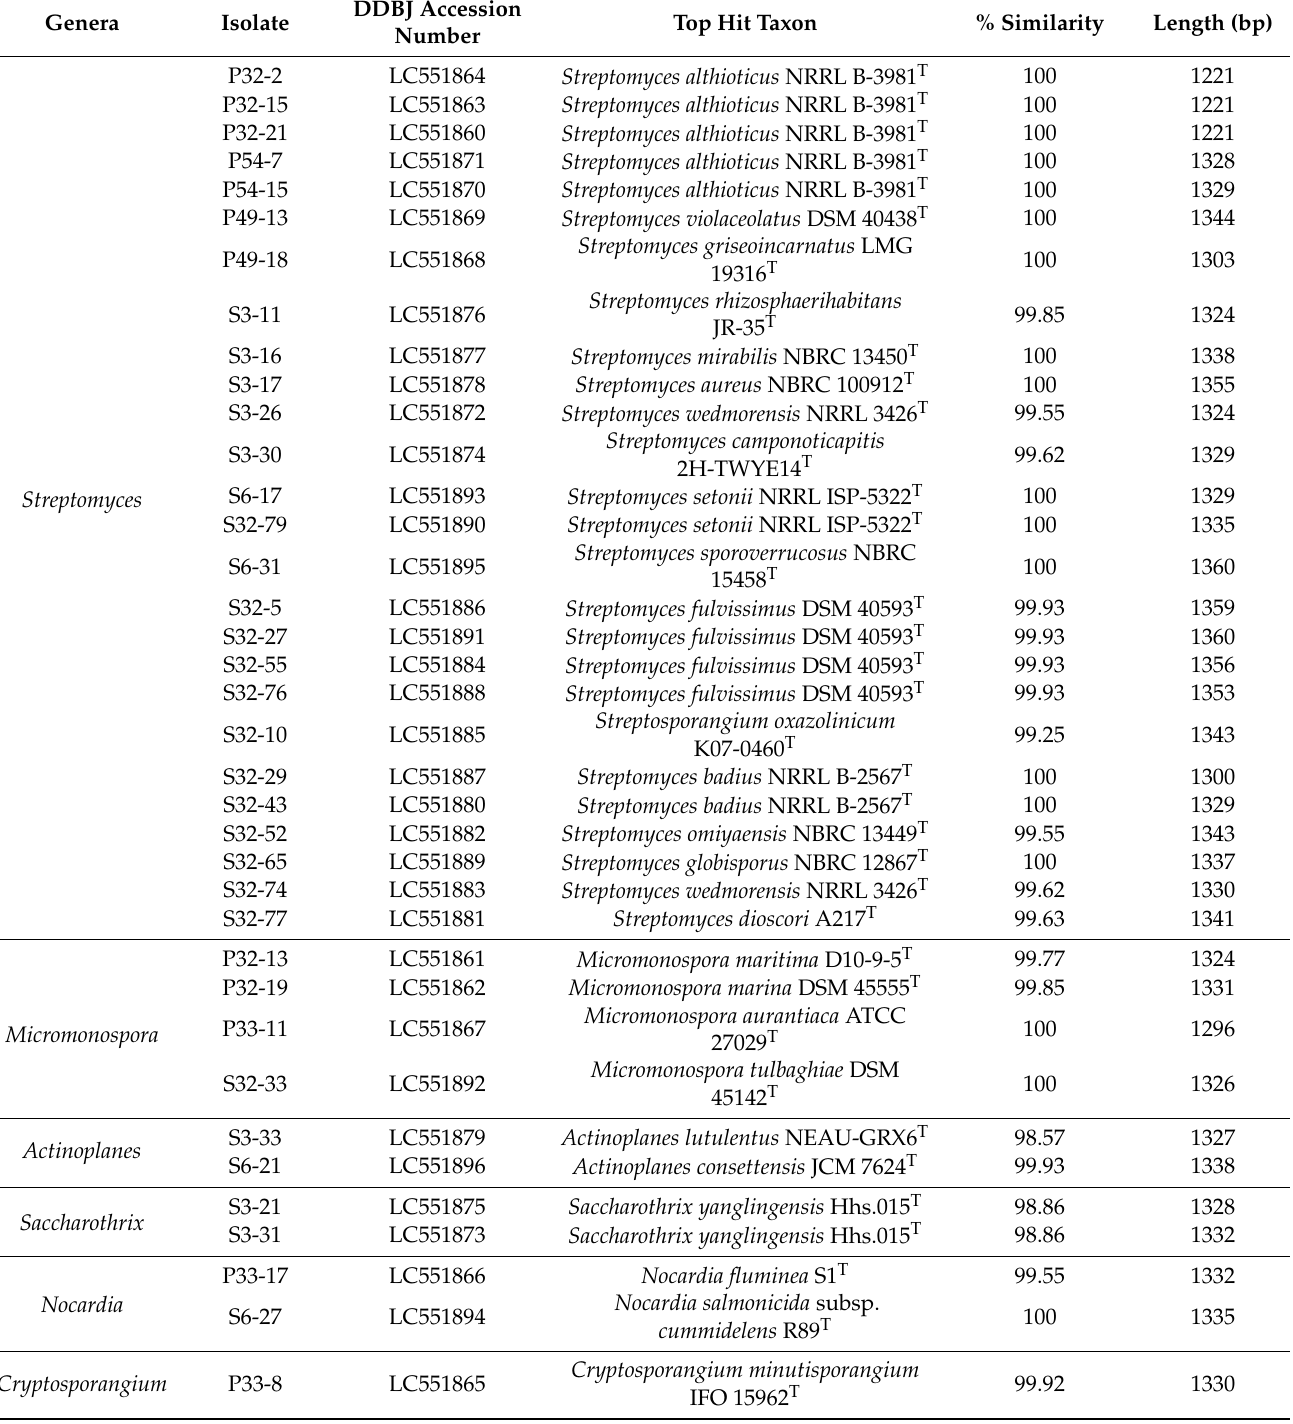
Table 3. 16S rRNA sequencing results of actinobacteria from mosses and comparisons with those in the EzBiocloud